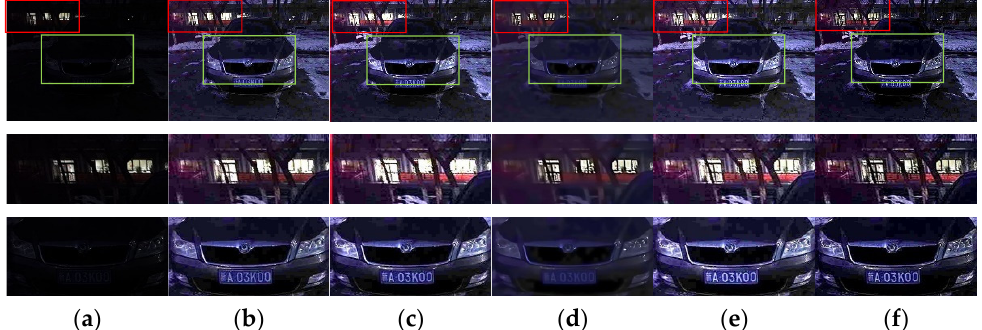
Figure 11. ( a ) Test image and its detail maps. The remaining images are the enhancement results and their detail maps, generated by the following methods: ( b ) ALSM, ( c ) Li et al. [26], ( d ) LR3M, ( e ) LIME, and ( f ) the proposed method.